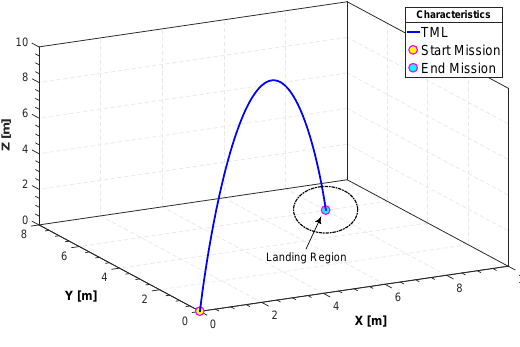
Figure 12. Three-dimensional take-off, mission and landing (TML)